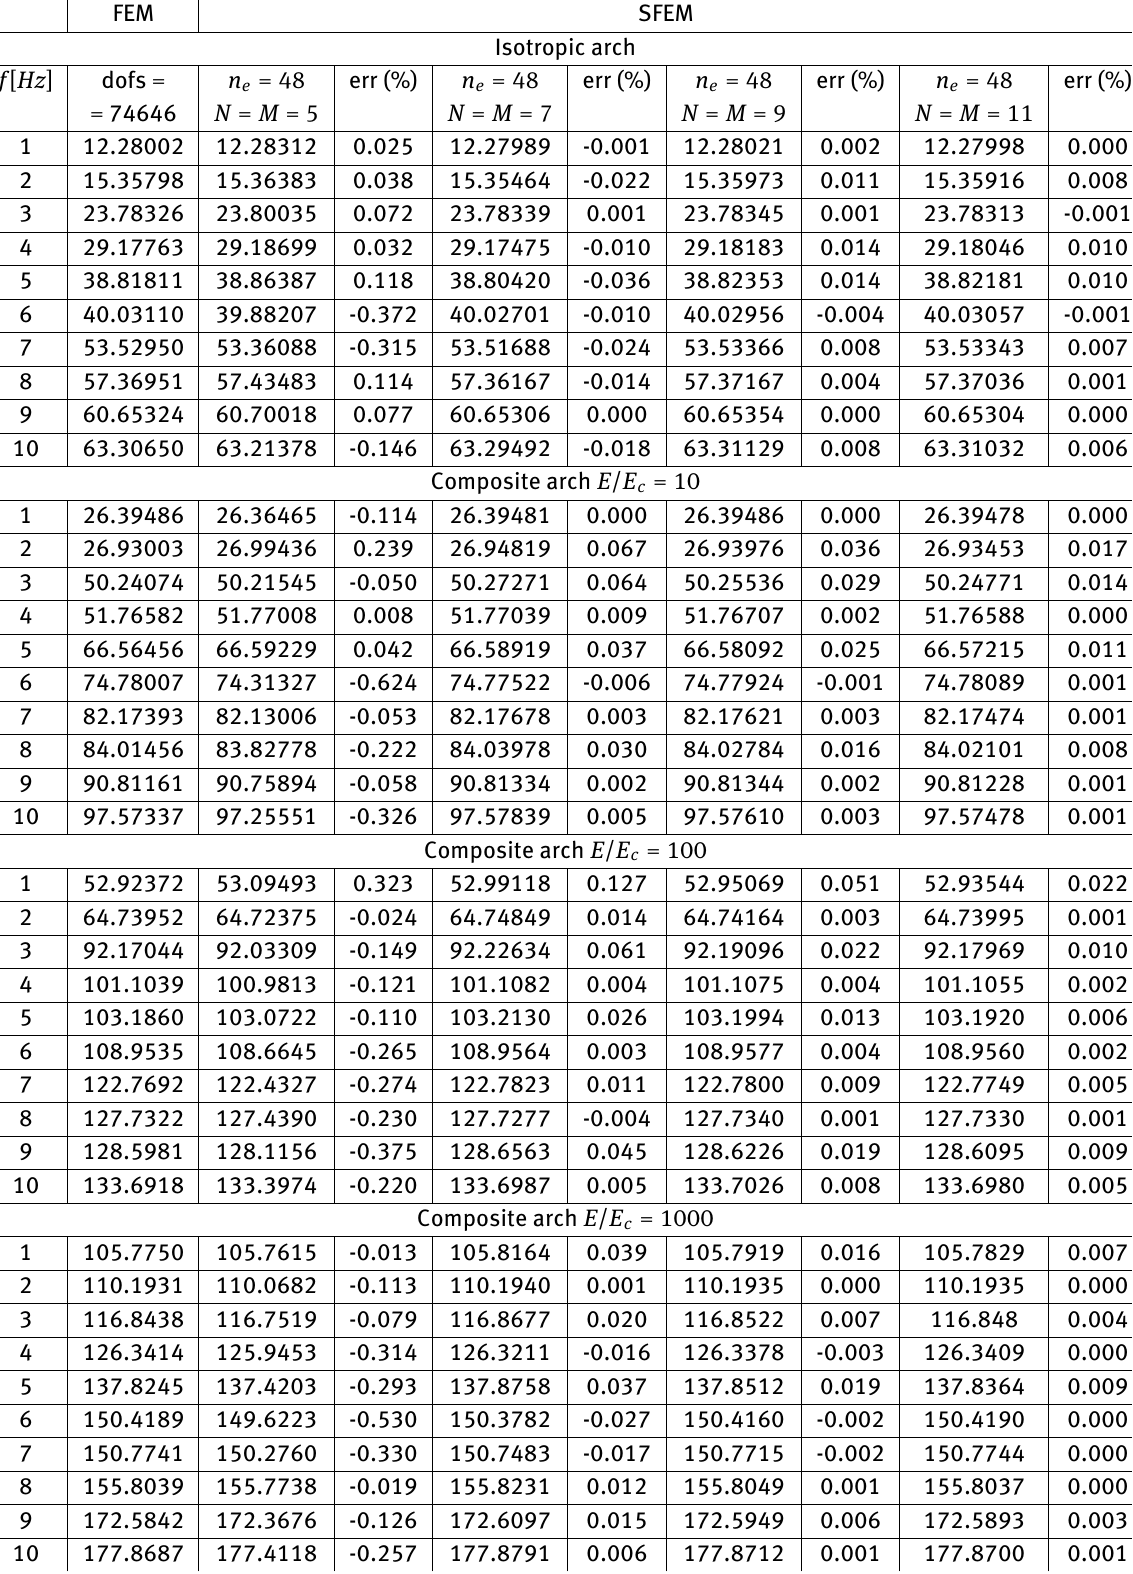
Table 7: First ten frequencies for a circular composite arch with circular holes, increasing the number of grid points per element.